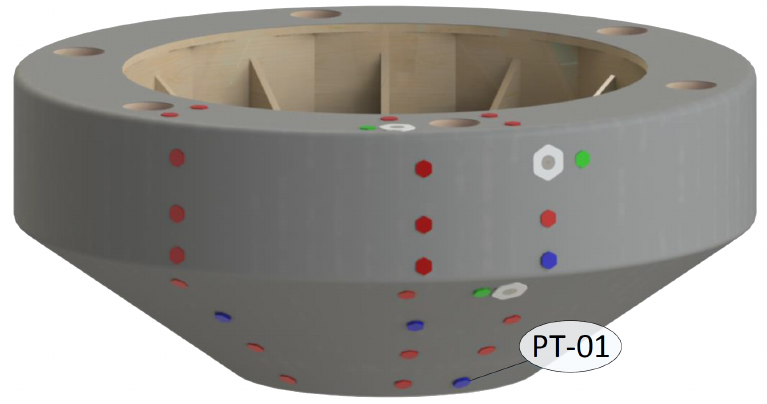
Figure 7. Pressure sensor locations on the hull of WEC test device.